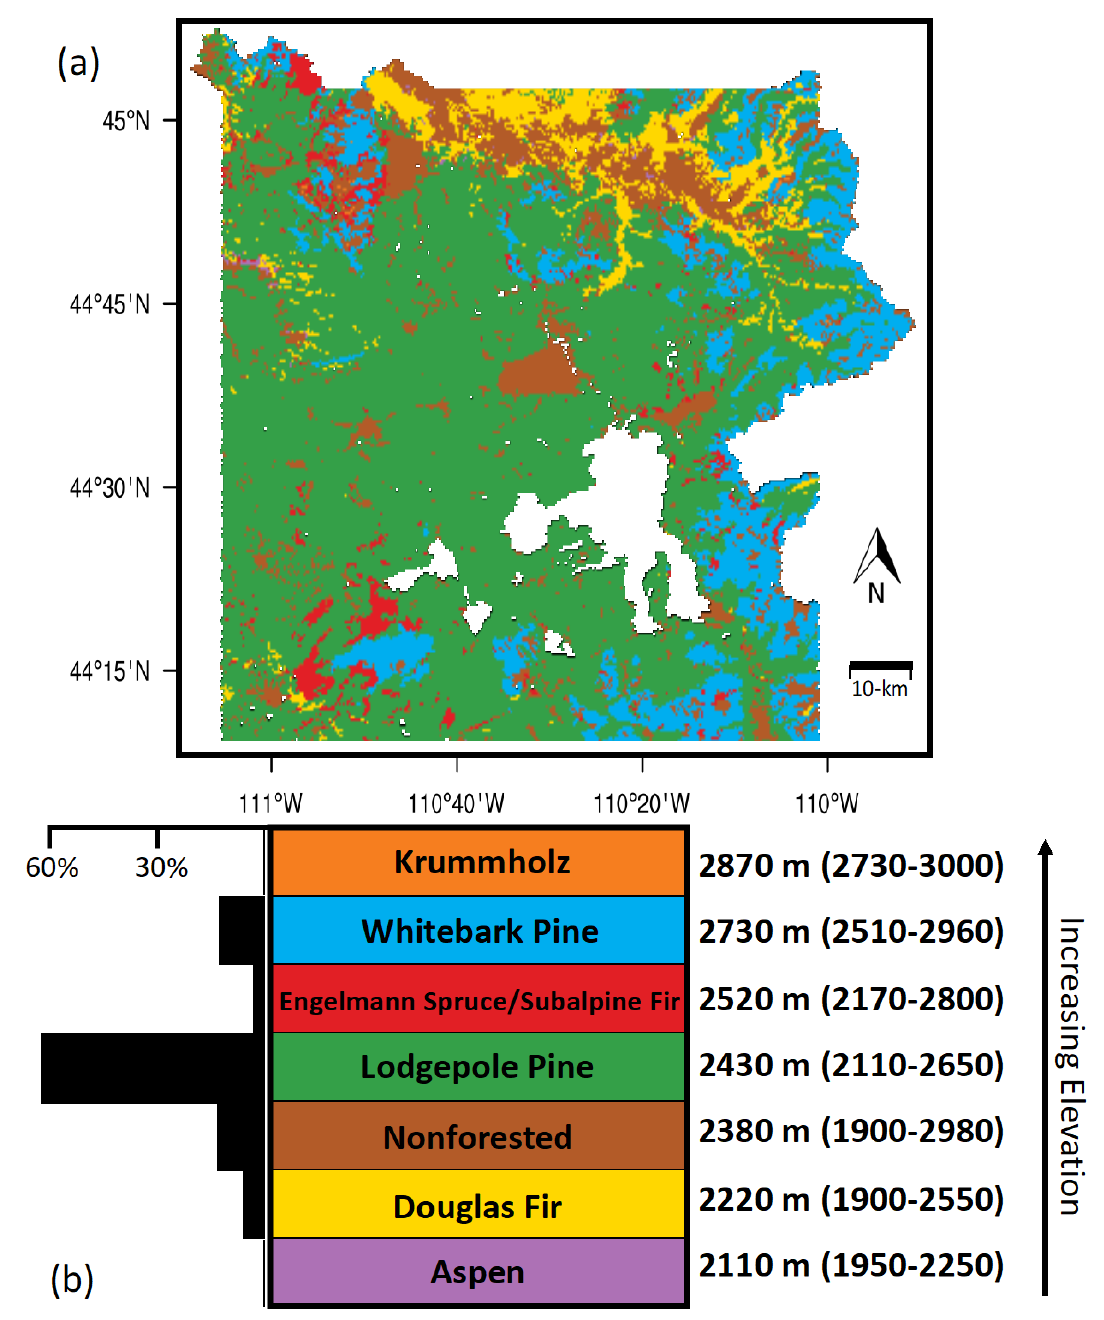
Figure 2. ( a ) Primary vegetation type distribution based on the National Park Service ’s (NPS) Yellowstone cover types data for 1999, following the species’ color scheme in ( b ). ( b ) Percent abundance (bar chart) of each vegetation type across the park and the mean elevation (m) for each type provided as text, along with the 5th and 95th percentiles of elevation in parentheses.